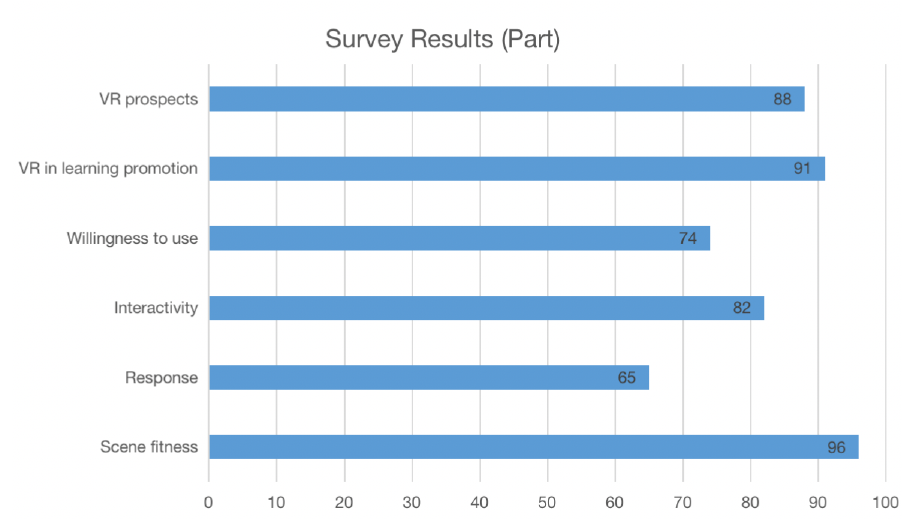
Figure 11. Survey results.